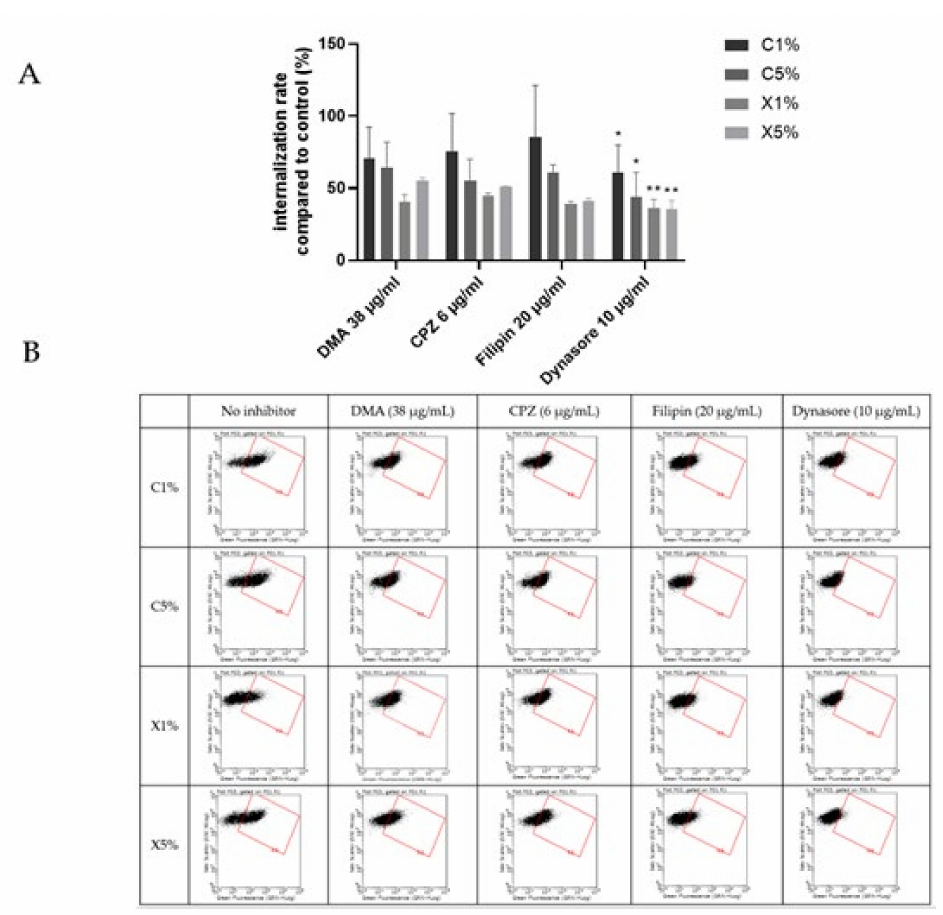
Figure 7. Results of the effect of endocytosis inhibitors on the uptake of cationic liposomes by BeWo cells. Internalization rates correspond to fluorescence from flow cytometry experiments relative to cells incubated with liposomes without inhibitors; data represent the mean ± SEM (n = 3 formulations), * indicates a significant difference compared to the control ( p < 0.01, Mann- Whitney) and ** indicates a significant difference compared to the control ( p < 0.001, Mann-Whitney); ( B ) Flow cytometry dot plots for liposomes internalization evaluation (green fluorescence, DOPE- NBD) after incubation with fluorescent cationic liposomes and lipoplexes (1 or 5% PEG) at 0.03 mM for 4 h with or without inhibitors dimethylamiloride (DMA), Chlorpromazine (CPZ), Filipin and Dynasore. ( A ) minimum of 15,000 cells/samples were